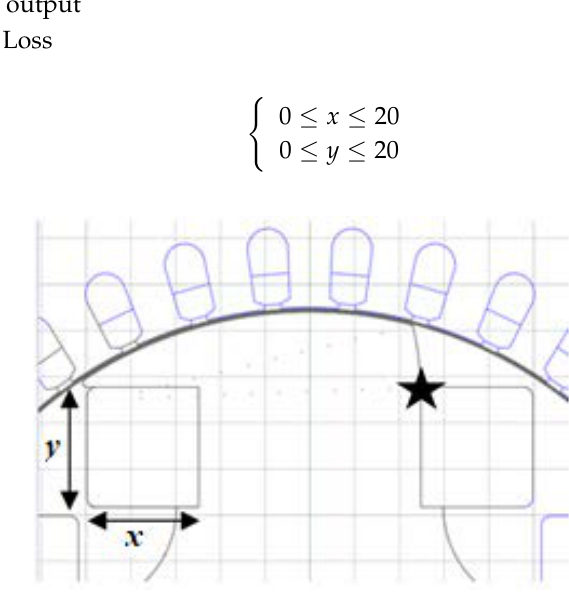
Figure 3. Problem definition A of Design 1.